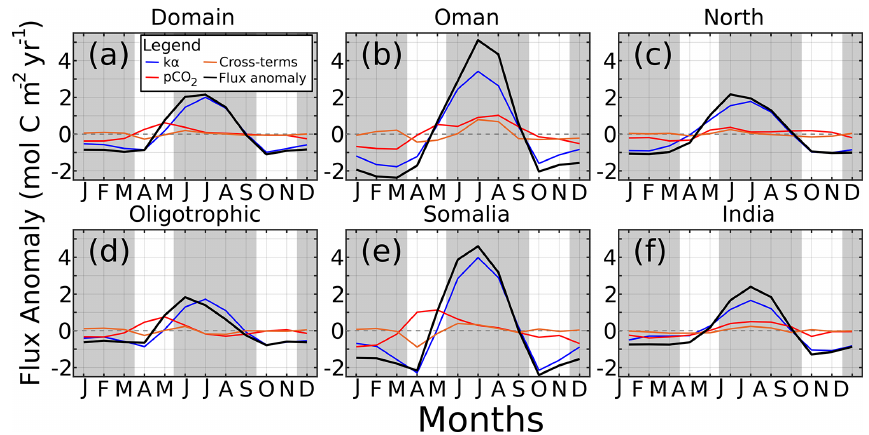
Figure 8. Monthly CO 2 air–sea flux anomaly (molCm − 2 yr − 1 ) for (a) the domain, (b) Oman, (c) north AS, (d) oligotrophic central AS, (e) Somali coast, and (f) Indian coast. Contributors to the flux are solubility and winds ( kα , blue), p CO 2 (red), and cross-terms (orange). Gray regions indicate winter and summer monsoons.